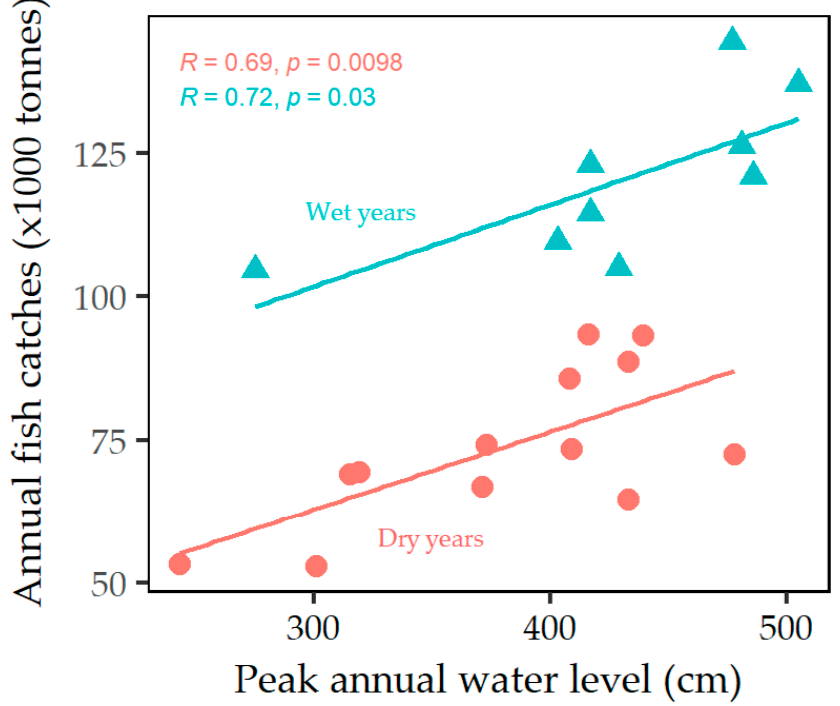
Figure 7. Relationships between fish catches and peak annual water levels. Data are as in Figure 6. Each point represents one year in the period 1995–2016. Upper line and data are for the wet period 1995–2003; lower line and data are for the dry period